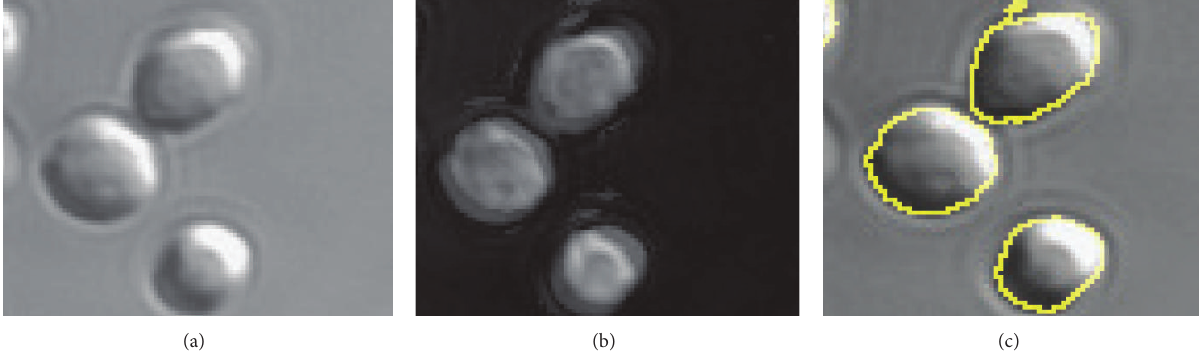
Figure 7: (a) DIC images of Methanosarcina acetivorans grown on methanol. (b) After applying Hilbert transform to DIC images and adding them to the original image, the boundaries of the cells become clearer. (c) CellProfiler is used to perform segmentation on images in (b). Here identified cell boundaries are superimposed onto original DIC image to illustrate